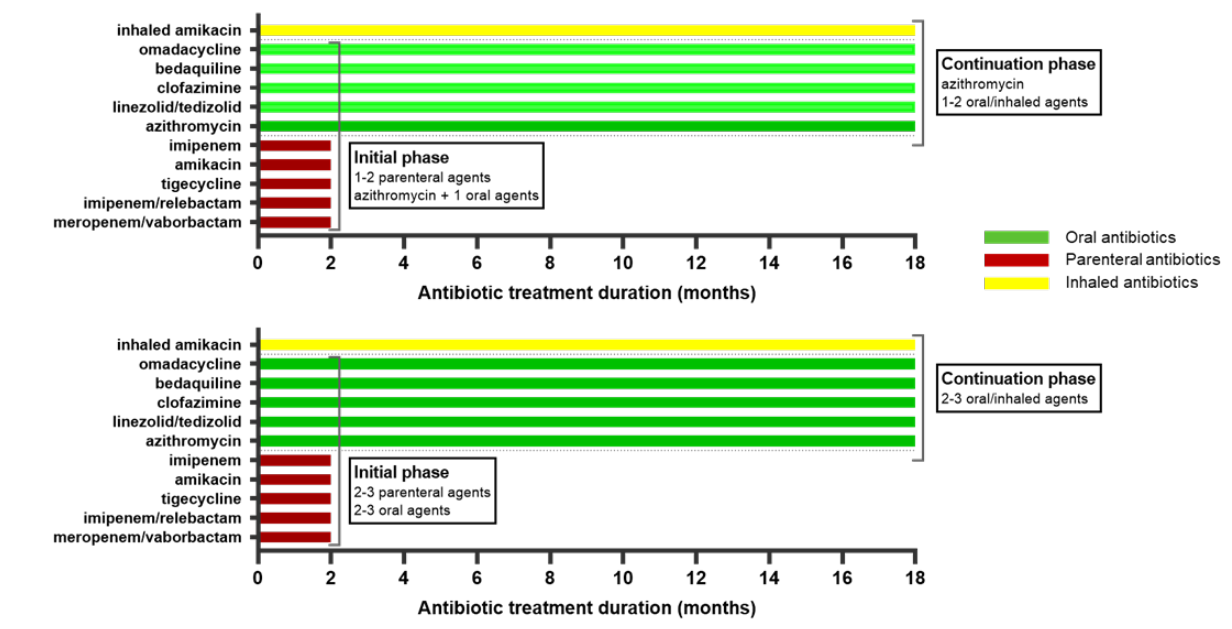
Figure 2. Antibiotic schedule for Mycobacterium abscessus complex infection. ( A ) Macrolide resistant strain. ( B ) Macrolide susceptible strain.